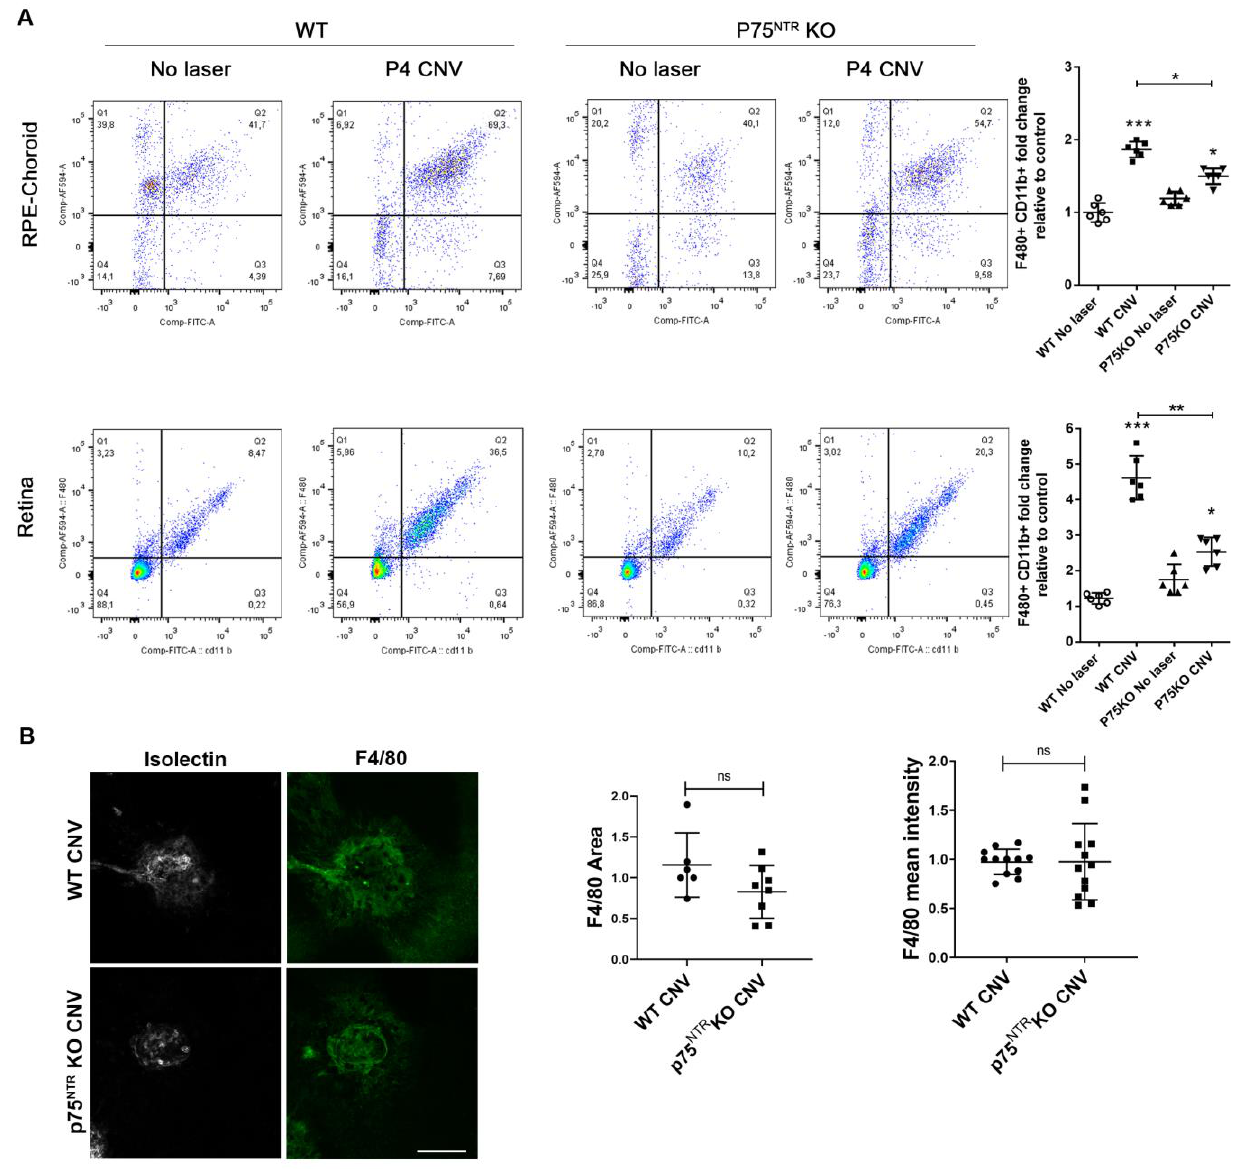
Figure 3. Reduced inflammatory phenotype in the RPE-Choroids and retinas of p75 NTR knockout mice, after laser injury. Mononuclear phagocytic cell recruitment is significantly reduced in retinas and RPE-Choroids of p75 NTR KO mice after CNV. ( A ) Representative flow cytometry pseudocolor plots from WT and p75 NTR KO mice without CNV, or 4 days after laser injury. Cells in the gate were quantified and the number of cells in the gate/total cells ratio is represented in the bar graph expressed as units relative to WT no laser control. Graphs denote the mean ± SD from triplicate experiments, n = 6 mice/group. The asterisks show statistical differences respect to control. * p < 0.05, ** p < 0.01, *** p < 0.001. ( B ) Representative confocal images of RPE-Choroid flat-mounts of WT and p75 NTR KO mice 4 days after laser, showing immunofluorescence staining with Isolectin IB-4 (grey) and F4/80 (green). Scale bar: 200 µm. F4/80 fluorescence intensity and area were quantified with ImageJ FIJI software Version 1.53t, and represented in the bar graph expressed as units relative to CNV WT control. Bars denote the mean ± SD from triplicate experiments, n = at least 5 mice/group. ns: non-significant.